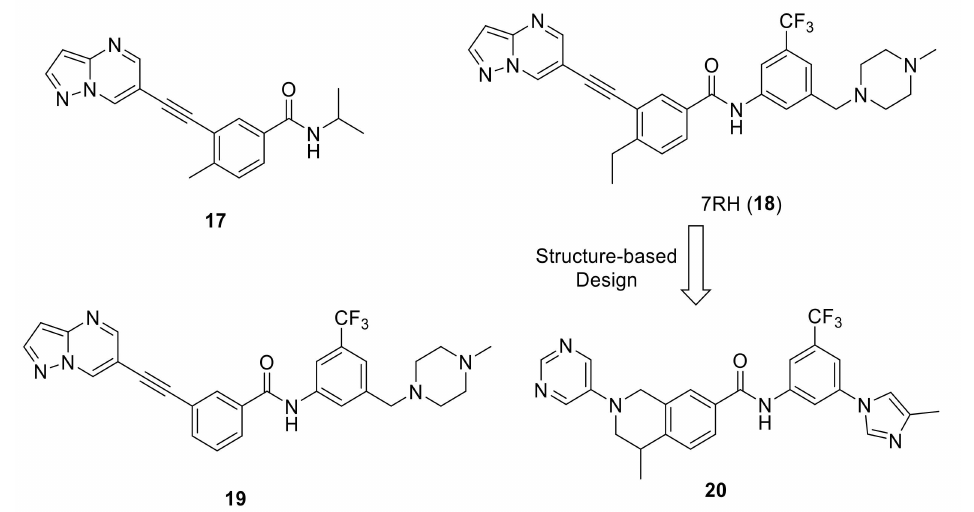
Figure 6. Chemical structures of DDR1inhibitors 17 , 18 (7RH), 19 , and 20